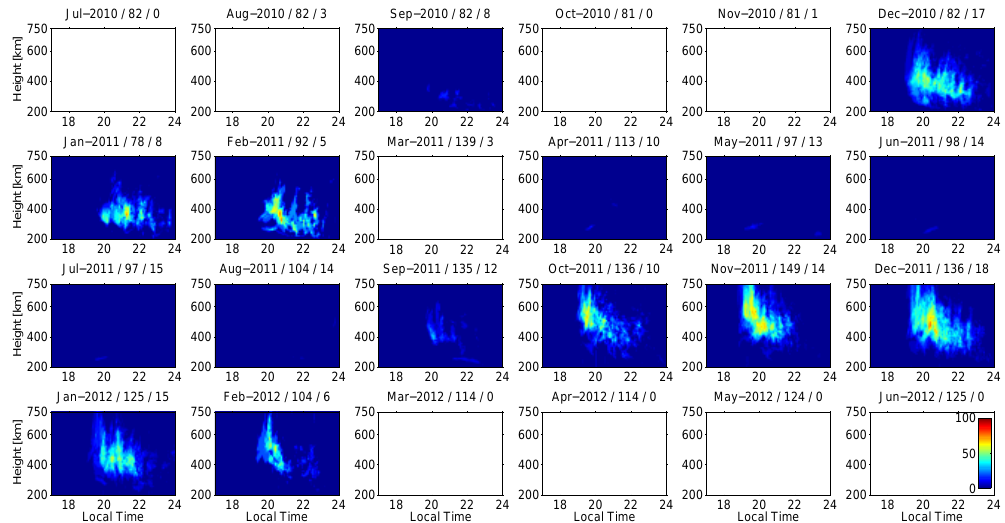
Figure 3. Monthly occurrence of F region echoes (SNR > 0dB) observed by the São Luis radar. Blank panels indicate months when ESF measurements were not made (radar did not operate) or less than five nights of observations were